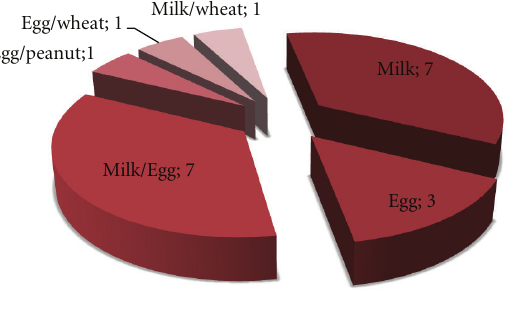
Figure 2: Sensitization to food allergens and their combinations (absolute numbers of sensitized infants) in the group of symptom- atic infants at 6 months of age ( n = 20).